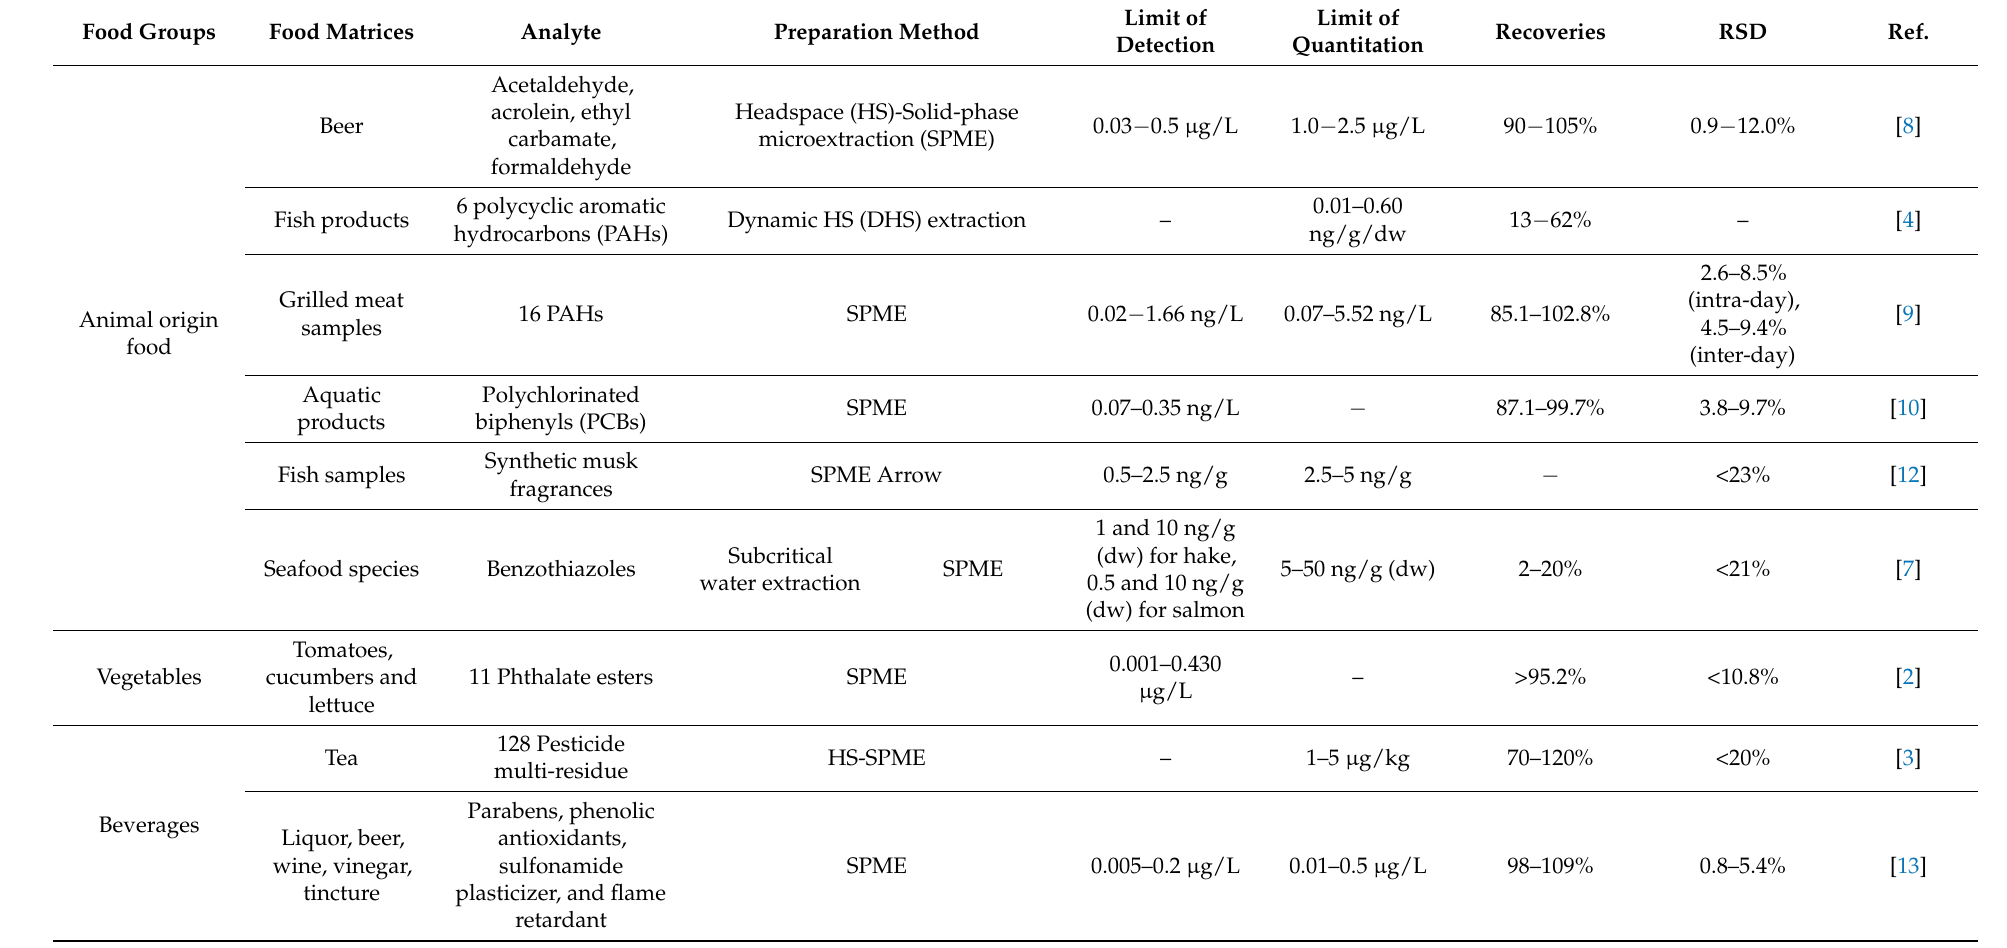
Table 1. Application of preparation methods for volatile organic compounds (VOCs) analysis in food by GC–MS/MS during the past three